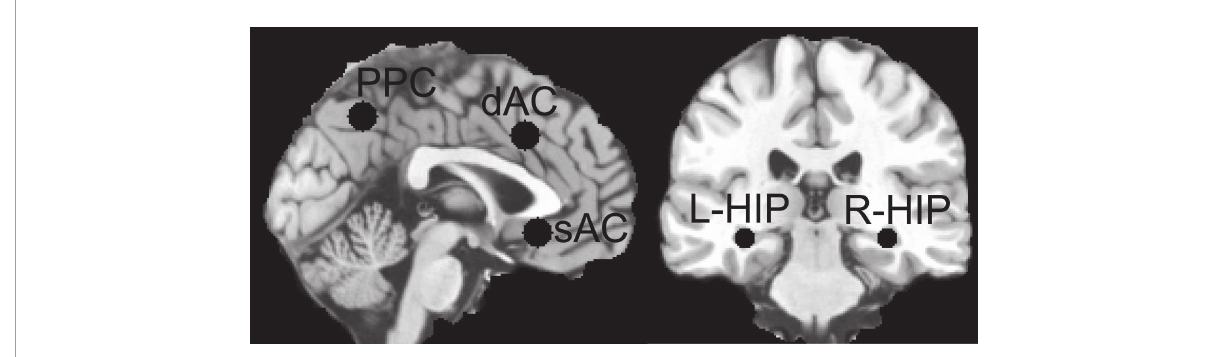
FIGURE1 Regions of Interest (ROI) used for sampling the electric field (EF) distributions; left hippocampus (L-HIP), right hippocampus (R-HIP) and for other abbreviations see main